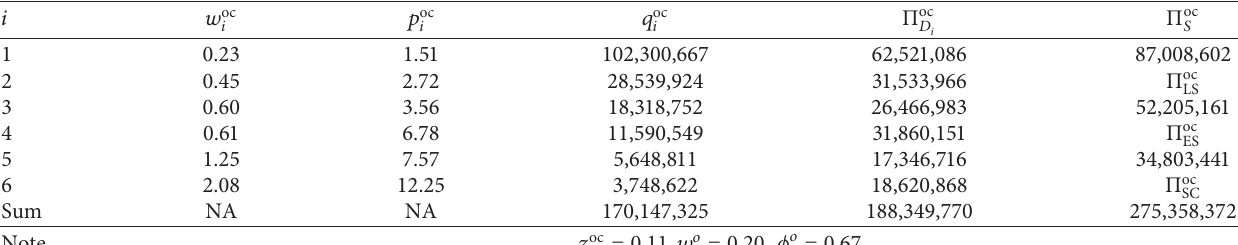
Table 5: Numerical analysis results of coordination decision without backlogging.